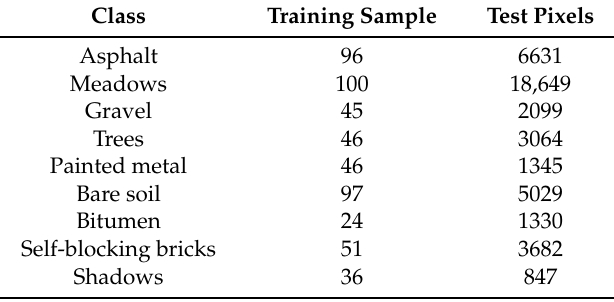
Table 2. Number of training samples and reference data for the Pavia University